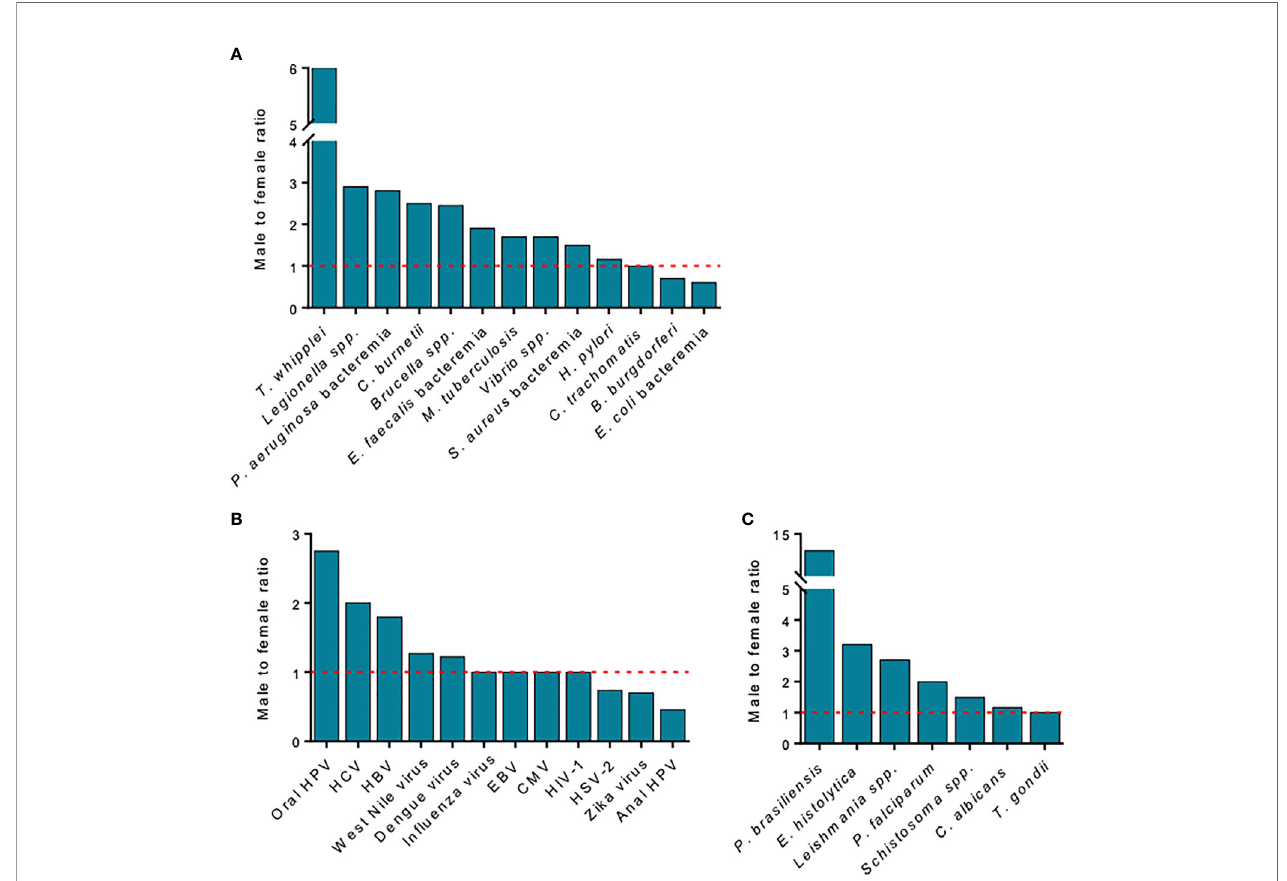
FIGURE 5 | Sex differences in the prevalence of infections. The male-to-female (M/F) ratios for different (A) bacterial, (B) parasitic and fungal, and (C) viral infections are presented. T. whipplei infection occurs in six men for every one woman, but prevalence is similar between men and women for Toxoplasma gondii infection, whereas anal HPV infections are more frequent in women. Data extracted from